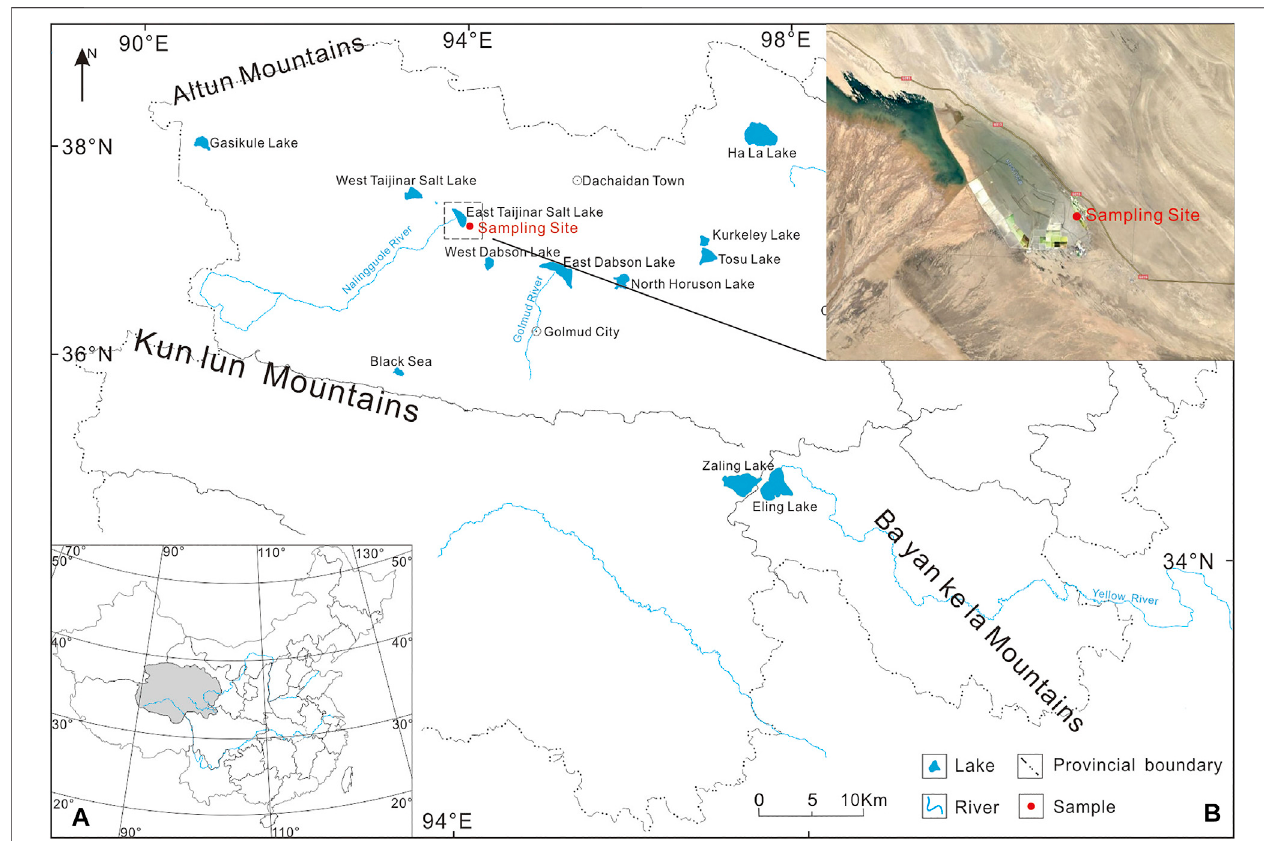
FIGURE1| MapofthesamplingsiteandlakesintheQinghaiProvince. (A) MapshowingthelocationofQinghaiProvinceinChinaand (B) Mapshowingthelocation of East Taijinar Salt Lake and the sampling site in the Qinghai Province.